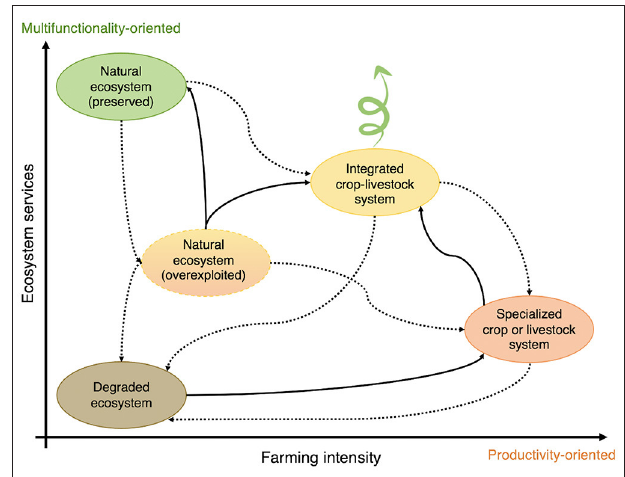
FIGURE 1 | Conceptual model of states and transitions in agroecosystems as a function of farming specialization and ecosystem services (ES) delivery. Solid and dotted lines denote positive and negative effects of the transition on ES delivery, respectively. Negative transitions could be caused by overexploitation of resources (e.g., overgrazing) or adoption of aggressive, non-conservationist agricultural practices (e.g., multi-pass tillage) or industrial livestock production (e.g., feedlots). Positive transitions could be promoted through sound grazing management practices (e.g., moderate grazing intensity), conservation agriculture practices (e.g., no-till and crop rotation diversity) and adoption of crop-livestock integration. Green arrow indicates that ES provided by integrated crop-livestock systems are potentially higher depending on synergisms levels (see explanation in the text). For clarity, only some possible states and transitions are